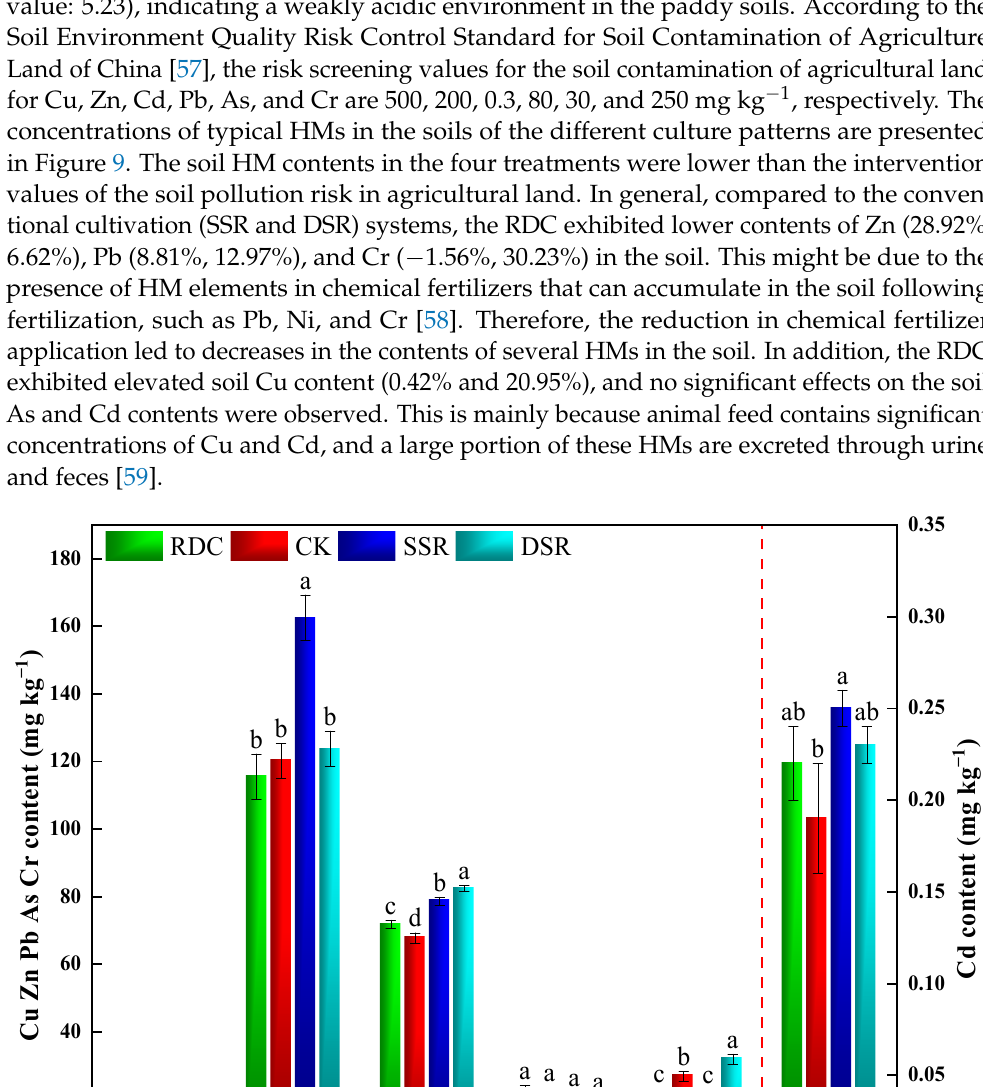
Table 2. Effects of different systems on the Nemerow index ( P N ).